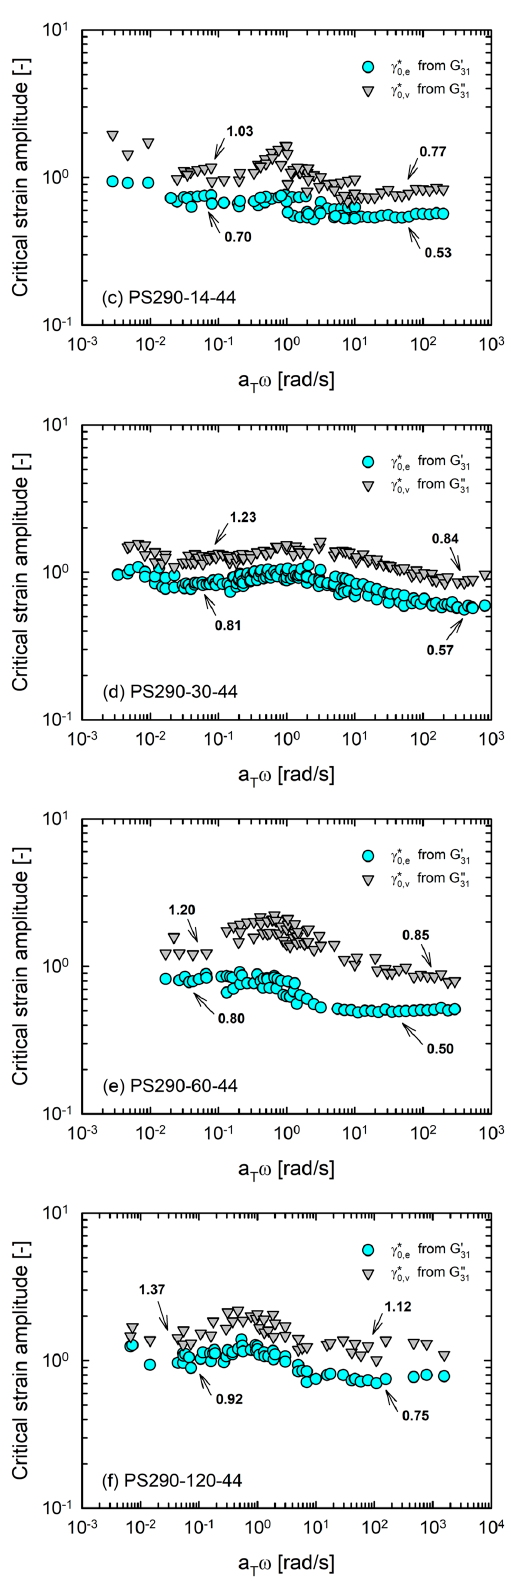
Figure 7. Critical strain amplitudes of model comb PS set as functions of frequency (Pipkin diagram) based on first-harmonic MAOS moduli. ( a ) PS290, ( b ) PS290-3-44, ( c ) PS290-14-44, ( d ) PS290-30-44, ( e ) PS290-60-44 and ( f ) PS290-120-44. The values represent the local minima in the